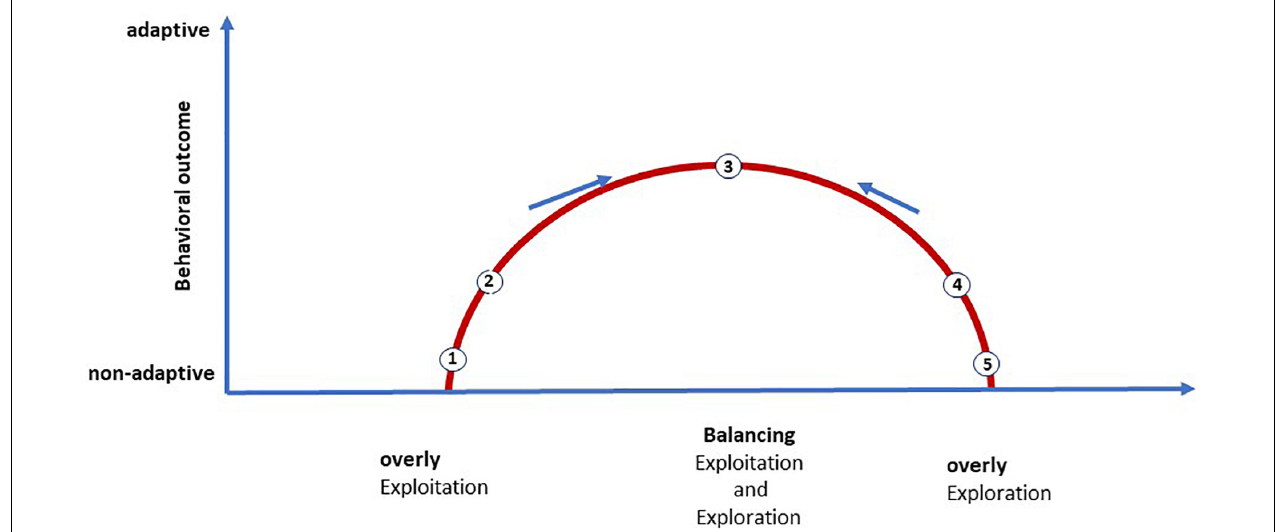
FIGURE 1 | The therapeutic course as an idealized exploration-exploitation-dilemma (red). Goal-directed therapeutic interaction starts at pole (1): Overly exploitation/non-adaptive behavioral outcome: At the beginning of therapy, the client is stuck and repeatedly maintains his dysfunctional pattern; free energy is very high. (2) Elaborating/validating the current model, work with emotions, starting guided reality checks in a safe environment, define experiments. More clarity, first success experiences, less free energy. (3) Balance/more adaptive behavioral outcome: both sufficient safety and sufficient experimentation, ratio may vary, directed exploration, thorough self-directed reality checks. Lowest possible value of free energy (4) Is there evidence that too much exploration, aimless experimenting leads to avoidance of key issues? Problems in therapeutic relationship? Increasing free energy. (5) Overly exploration/non-adaptive behavioral outcome: many new behavioral projects are started but not finished, impulsivity, too much new information, inefficient use of behavioral experiments, no robust learning experience and change, risk of falling back into the grip of the dysfunctional internal model. Free energy is very high again.